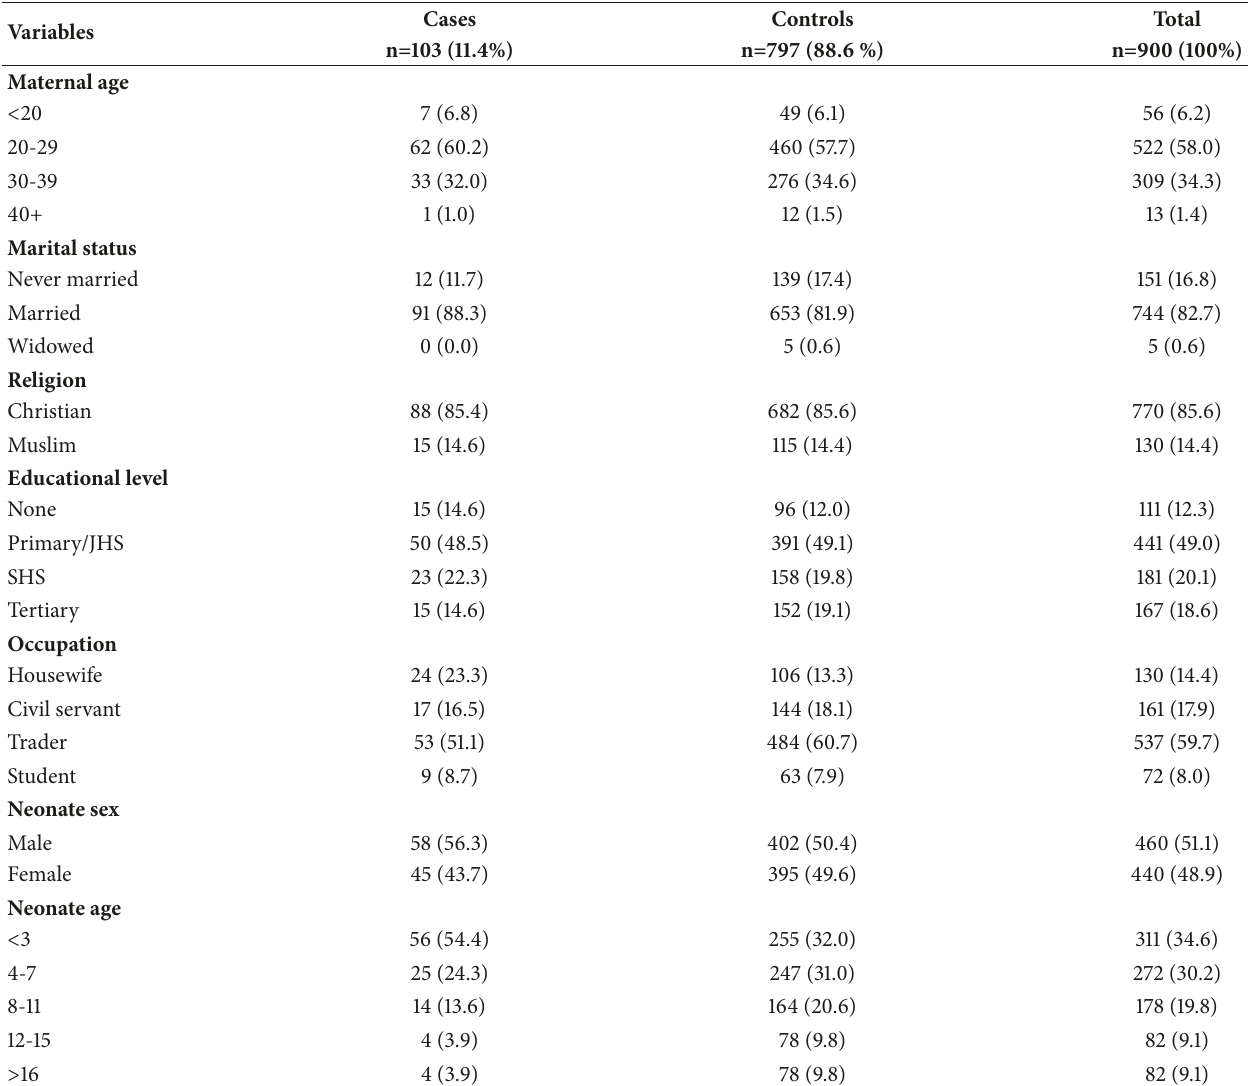
Table 1: Sociodemographic characteristics of cases and controls attending the Trauma and Specialist Hospital.